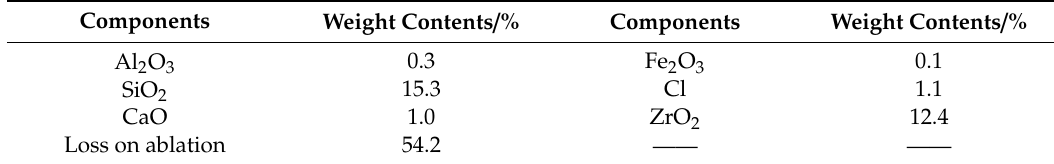
Table 3. XRF result of